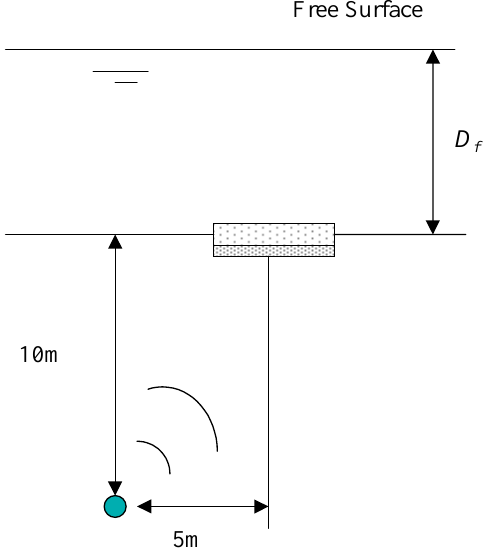
Fig.9. Schematicdiagramoftheshipsectionsubjectedtounderwater explosive